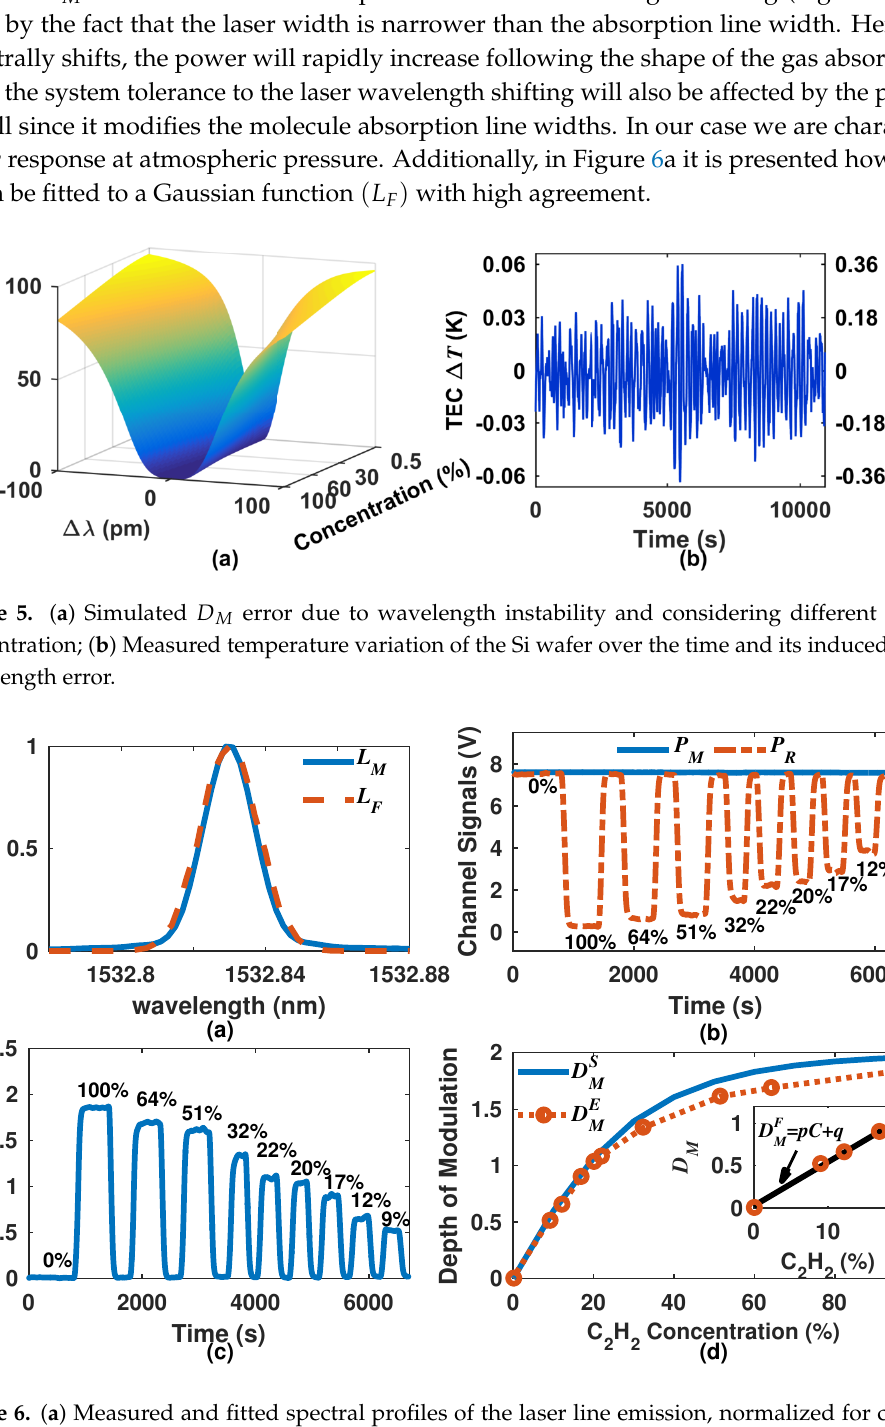
Figure 6. ( a ) Measured and fitted spectral profiles of the laser line emission, normalized for clarity purposes. ( b ) Channel signals, as a function of time, showing the effect of changing the C 2 H 2 concentration. ( c ) Calculated depth of modulation as a function of time showing the effect of changing the C 2 H 2 concentration. ( d ) Measured and simulated depth of Modulation as a function of the C 2 H 2